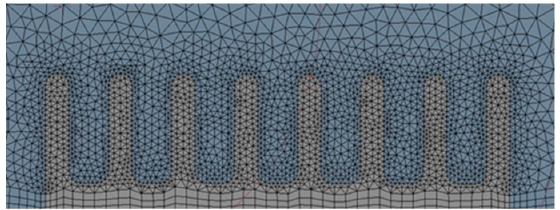
Figure 3. Part of the mesh.